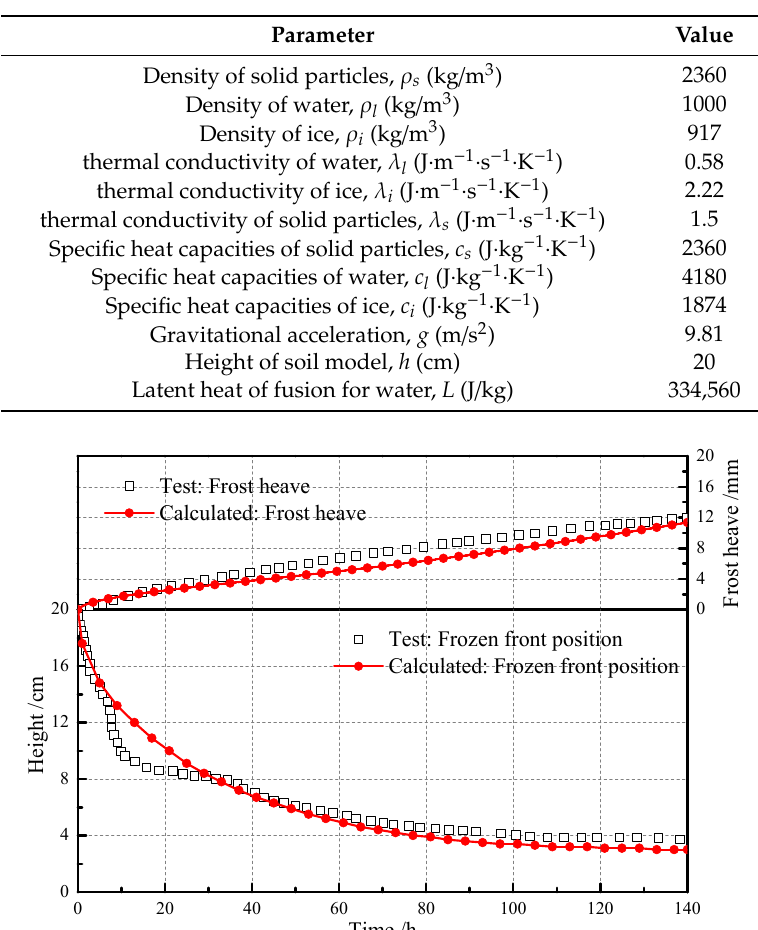
Table 1. List of parameters used in the model validation.